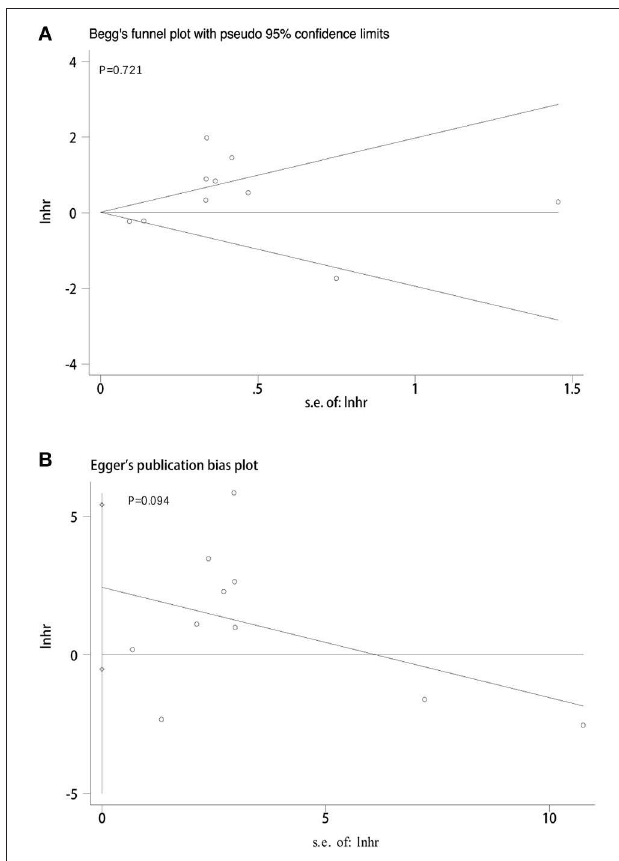
FIGURE 8 | Publication bias tests between PD-L1 expression in TCs and OS. (A) Begg’s funnel plot; (B) egger’s funnel